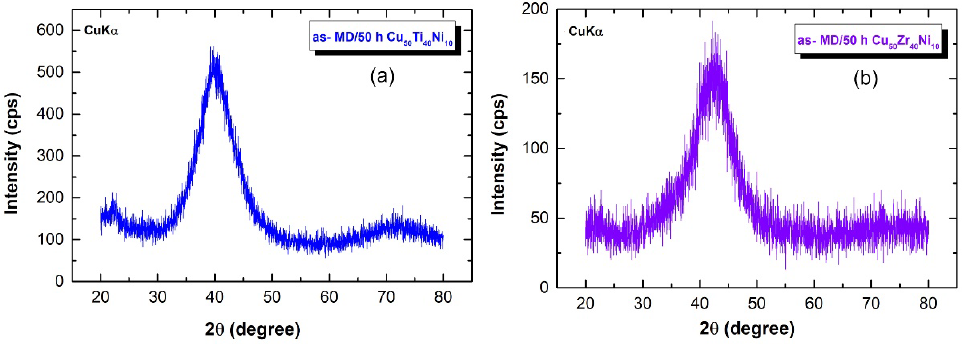
Figure 10. XRD patterns of as-arc-melt buttons that were high-energy ball milled for 50 h of MD time for ( a ) Cu 50 Ti 40 Ni 10 and ( b ) Cu 50 Zr 40 Ni 10 powders. The morphological characteristics of the Cu 50 Ti 40 Ni 10 and Cu 50 Zr 40 Ni 10 amorphous powders obtained after 50 h of MD time are presented in Figures 11a and 11b, respectively. After this final stage of milling, the powders consisted of aggregated particles and possessed nearly spherical-like morphologies with an apparent particle size ranging between 0.35 µ m and 2.1 µ m, as shown in Figure 11.